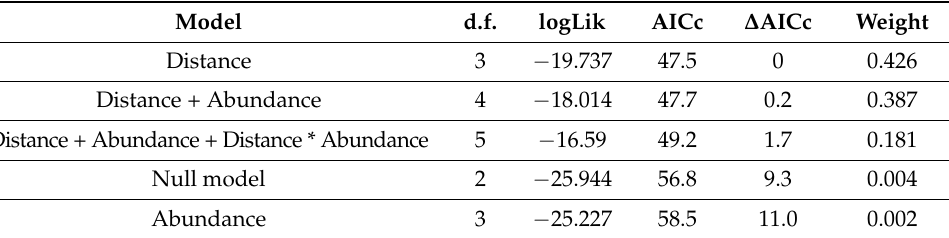
Table 1. The ranking of models investigating the recolonization time of Feral Pigeons based on AICc descriptions. Model parameters and estimates are presented for all possible models. The variables are Distance: the distance to the nearest colony of Feral Pigeons (m), Pigeons: the abundance of Feral Pigeons at the end of the control programme, and Distance * Pigeons: the interaction between the covariates.